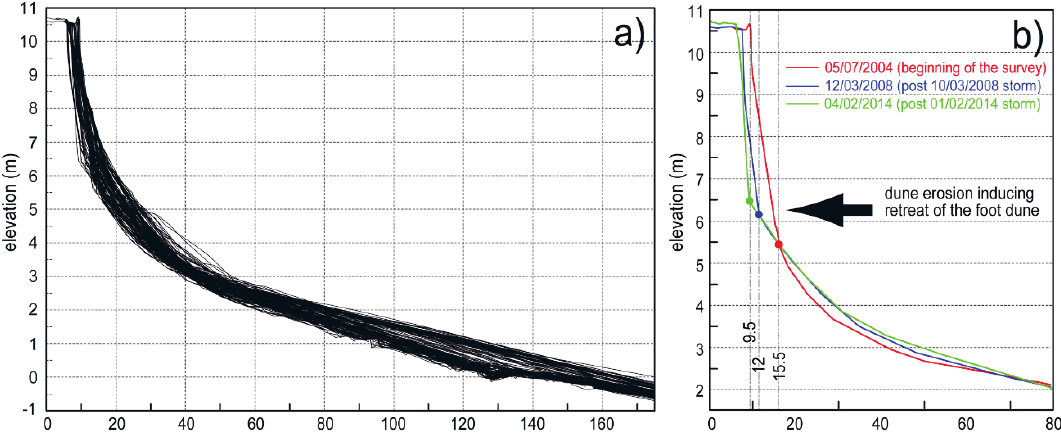
Figure 10. Envelop of beach/dune profiles measured from July 2004 to December 2014 ( a ); The front of the dune retreated during the two main storm events, which took place during the past 10 years ( i.e. , 10 March 2008 and 1 February 2014) inducing landward displacement of the foot of the dune ( b